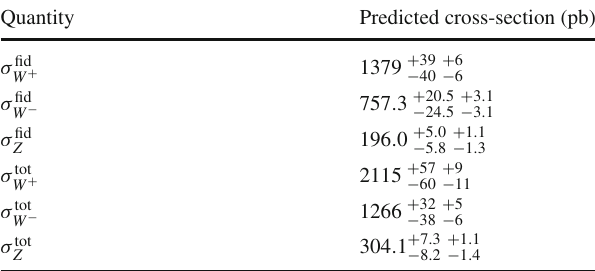
and ATLAS-epWZ12nnlo PDF sets. The dynamic scale, m (cid:3)(cid:3) ,